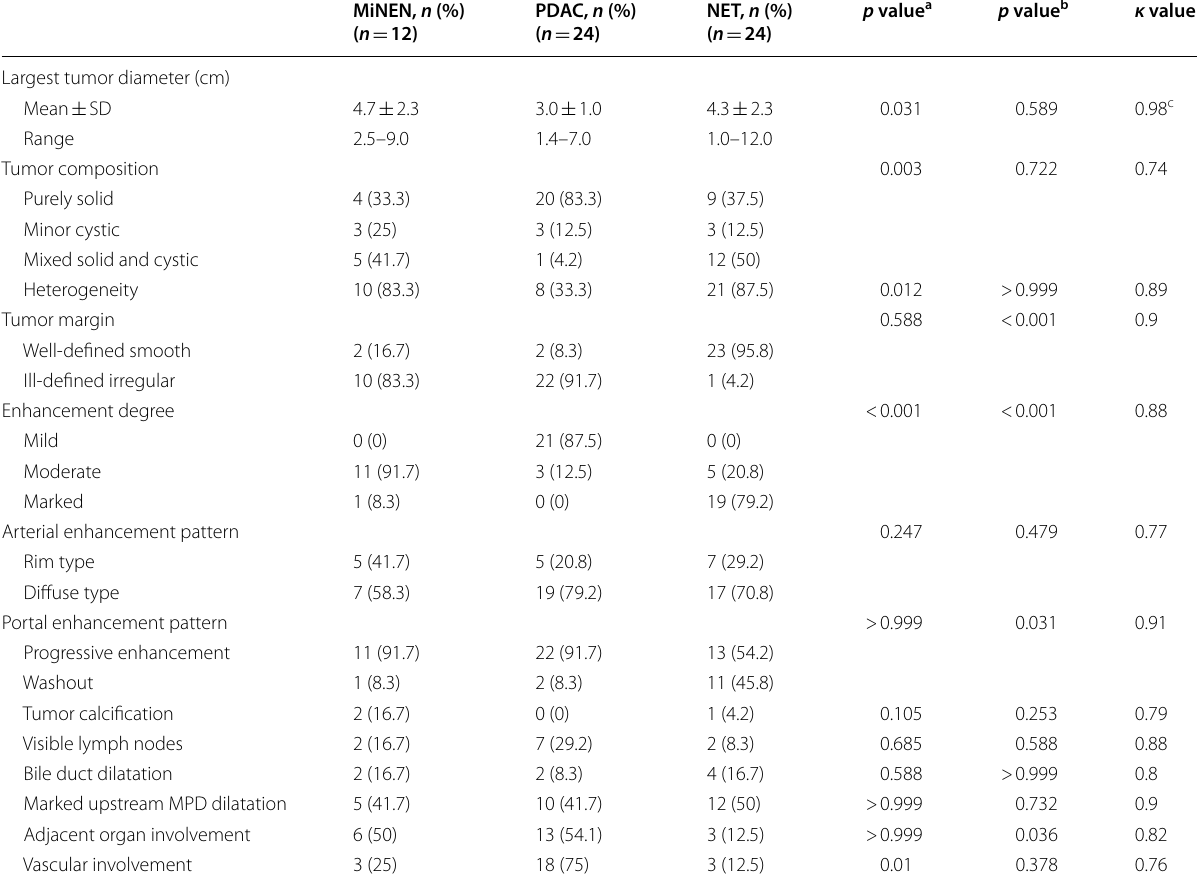
Categorical variables are described as the number of patients with the percentage in parentheses CT , computed tomography; MRI , magnetic resonance imaging; MiNEN , mixed neuroendocrine–non-neuroendocrine neoplasm; PDAC , pancreatic ductal adenocarcinoma; NET , neuroendocrine tumor; MPD , main pancreatic duct a Comparison between MiNEN and PDAC; b comparison between MiNEN and NET; c Intraclass correlation coefficients with 95% CIs were calculated for largest tumor